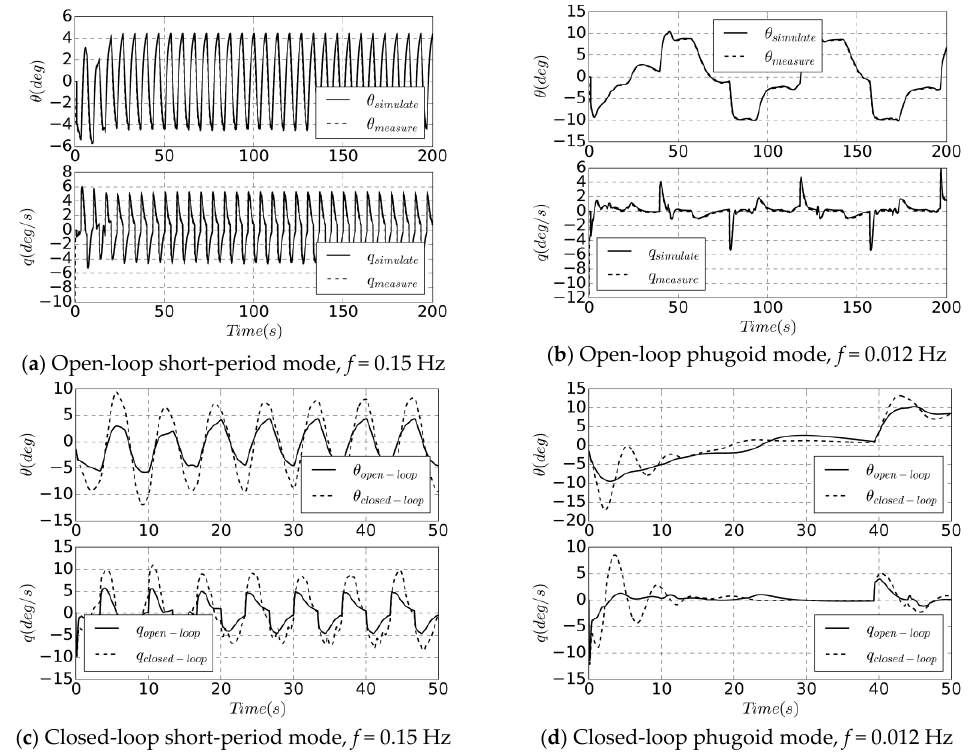
Figure 18. HILS open-loop and closed-loop experiment results.